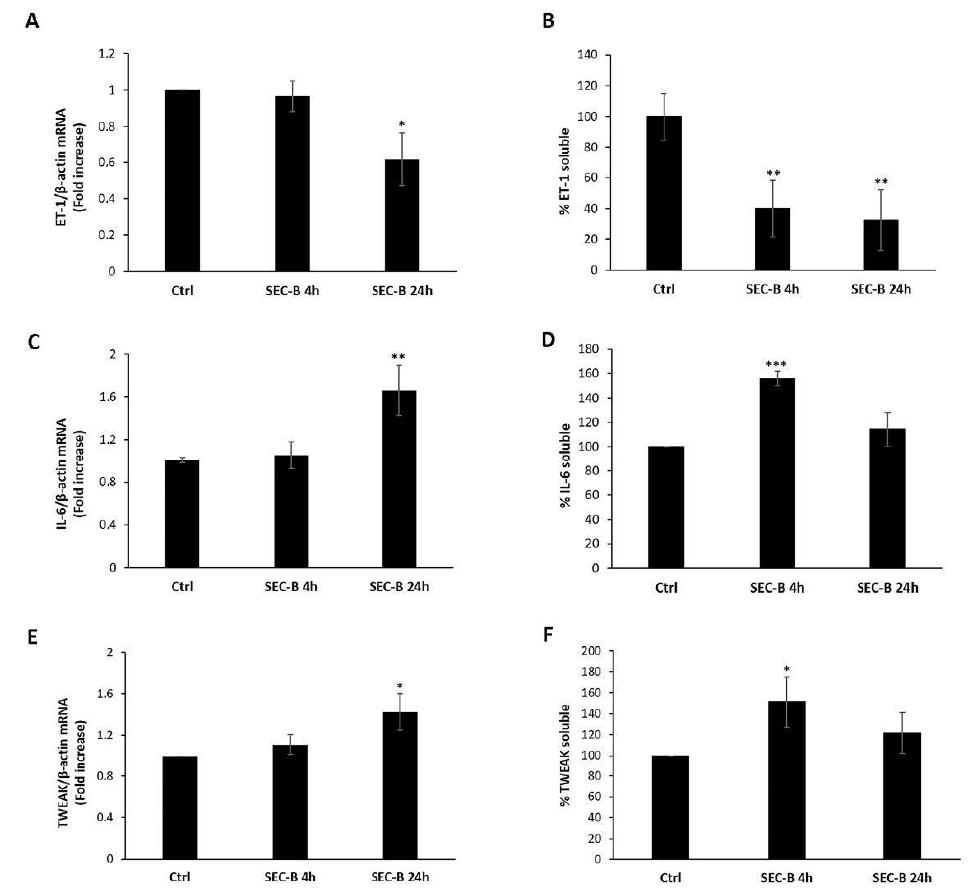
Figure 4. Effect of SEC-B on ET-1 and cytokine expression and secretion in HMEC-1 cells. Real-time PCR analysis of ET-1 ( A ), IL-6 ( C ) and TWEAK ( E ) mRNA expression at 4 h and 24 h post-treatment in cells treated with SEC-B. Data are normalized with β -actin mRNA. Quantitation of soluble ET-1 ( B ), IL-6 ( D ) and TWEAK ( F ) in the culture medium after 4 h and 24 h of SEC-B treatment by ELISA. Concentrations of soluble biomarkers (calculated as pg/mL) are expressed as % vs. untreated cells (Ctrl, set to 100%). Data are expressed as mean ± SD ( n = 3). * p < 0.05; ** p < 0.01; *** p < 0.001 vs. untreated cells.